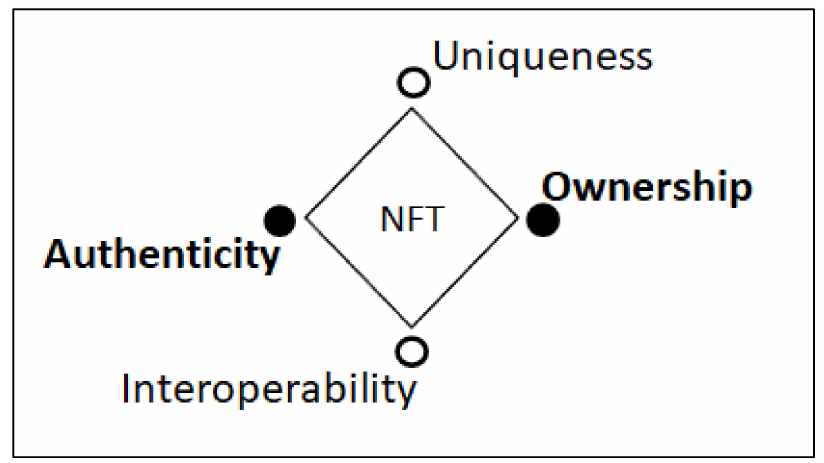
Figure 5. Main properties of a non-fungible token